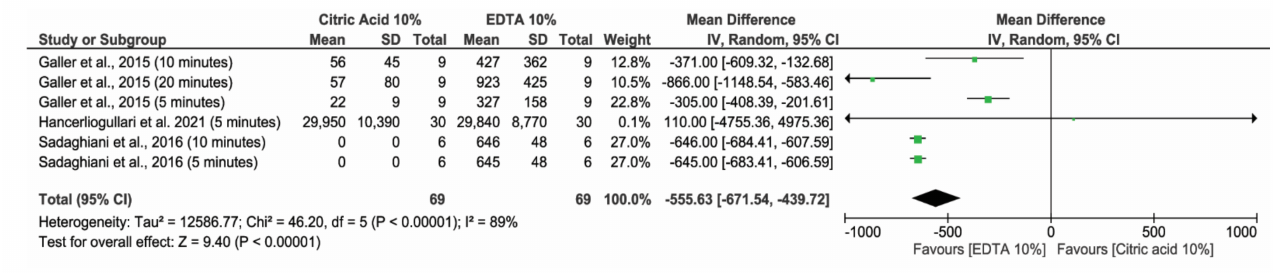
Figure 2. Forest plot for comparisons of TGF- β 1 detected by ELISA method after exposure to 10% EDTA versus 10% citric